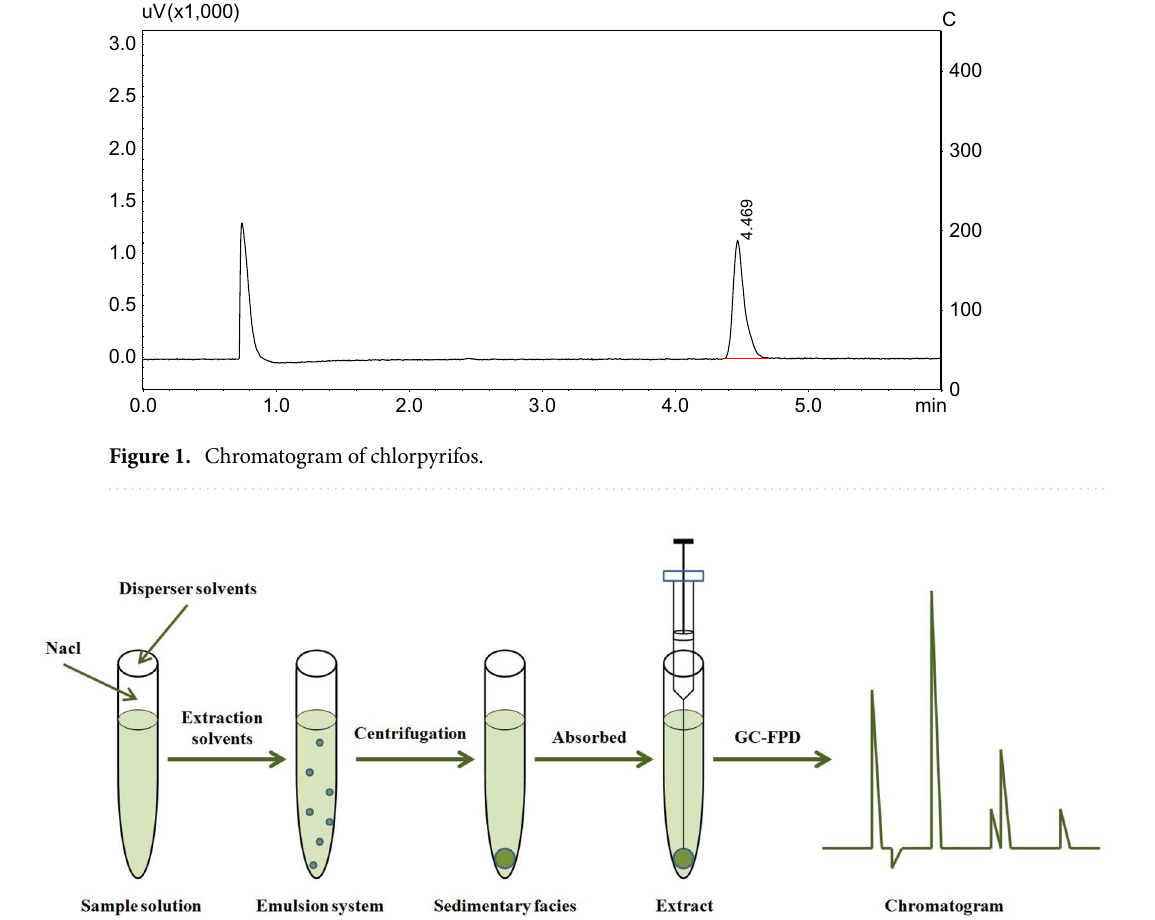
Figure 2. The schematic diagram of the sequential DLLME method.